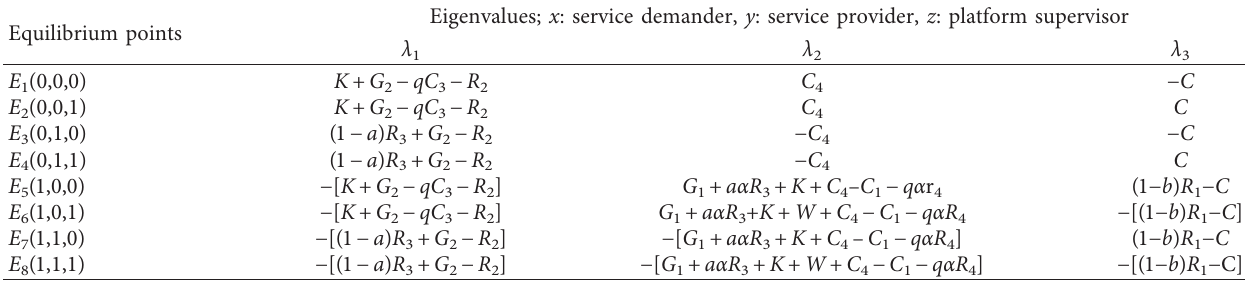
Table 3: System Equilibrium points and Eigenvalues.